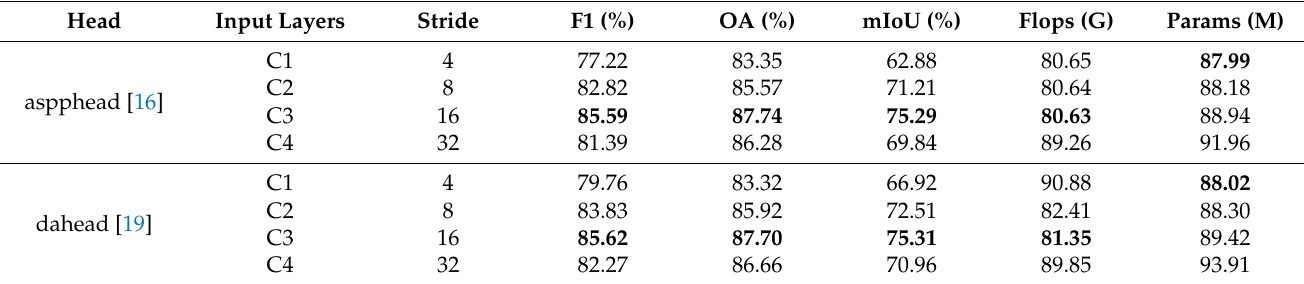
Table 6. The results of aspphead and dahead with different input